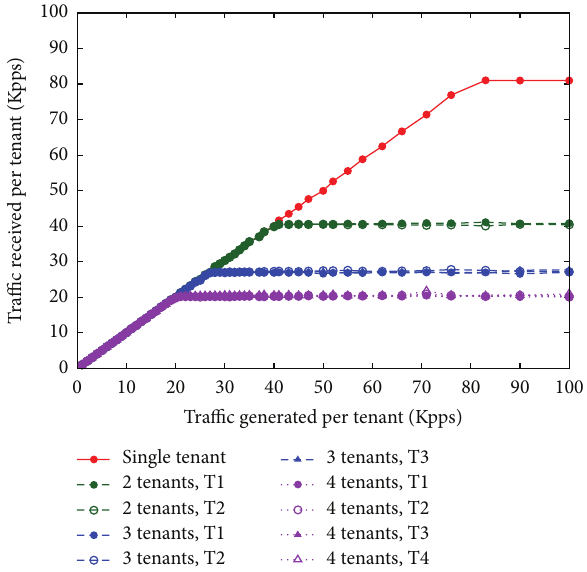
Figure13:Receivedversusgeneratedpacketrateforeachtenant(T1, T2, T3, and T4), for different numbers of active tenants, with 1500 - byte IP packet